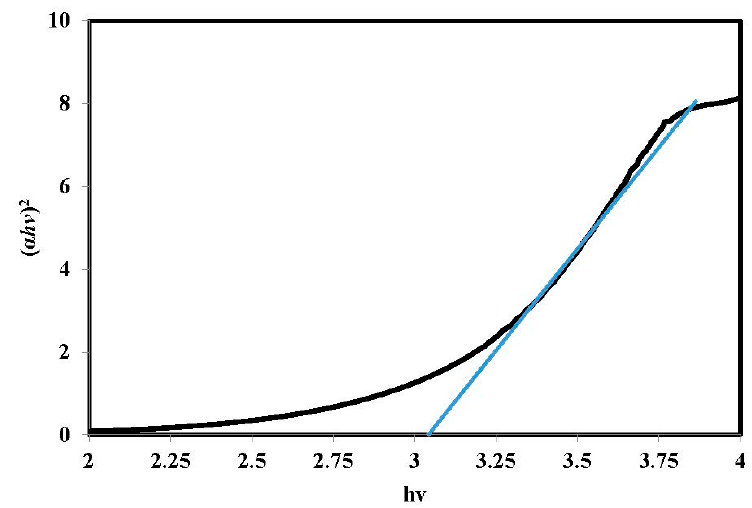
Figure 7. Direct band gap energy ( E g ) calculation. Table 5. Band gap ( E g ) of TiO 2 with several wt % of Er 3+ and Ni 2+